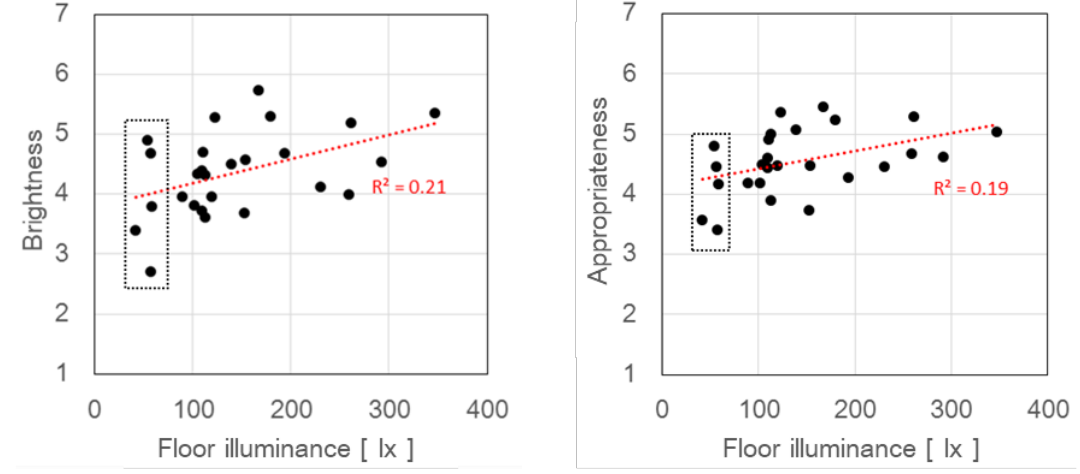
Figure 20. In the case of brightness, as the average values at five points distributed around 50 lx varied widely, ranging from 2.7 to 4.9, it is thought that floor illuminance only is insufficient to explain the brightness felt by humans. Among the five points, the points with the highest brightness evaluations corresponded to Nos. 17 and 25. Both places are side platforms and possess good vertical illuminance because there is a wide surface where light is reflected. In particular, at No. 25, a globe-shaped device, a lighting device prone to glare, was installed, but the overall impression evaluation results were excellent. This suggests that a lighting environment providing a sense of safety can be established, even if the line light source is not concentrated at the edge of the platform. In particular, with the spread of platform screen doors, it is no longer necessary to limit the location of the lighting to the edge of the platform. It is time for a plan to secure both a diverse platform lighting environment and the brightness of a space simultaneously. Furthermore, among the five points, the point with the lowest brightness evaluation is No. 19, and as described above, it is difficult to secure vertical illuminance because the reflective surface is insufficient due to the nature of the island platform. As such, there are factors to be considered in addition to the physical brightness. In particular, consideration of the reflective surface is essential in lighting design, and a plan tailored to these conditions is required.